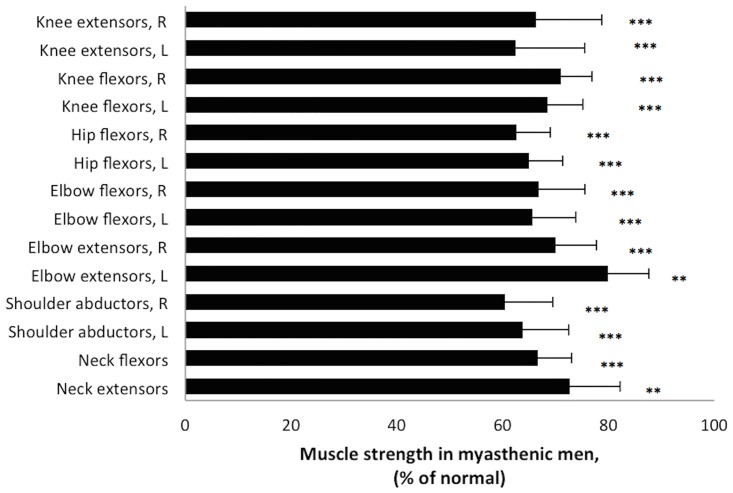
Muscle strength in men with generalized myasthenia gravis.Muscle strength in eight muscle groups in myasthenic men assessed by hand-held dynamometry, expressed as percentage of mean normative values (corresponding to 100%). L = left side and R = right side. ** = p<0.005 and *** = p<0.0001.